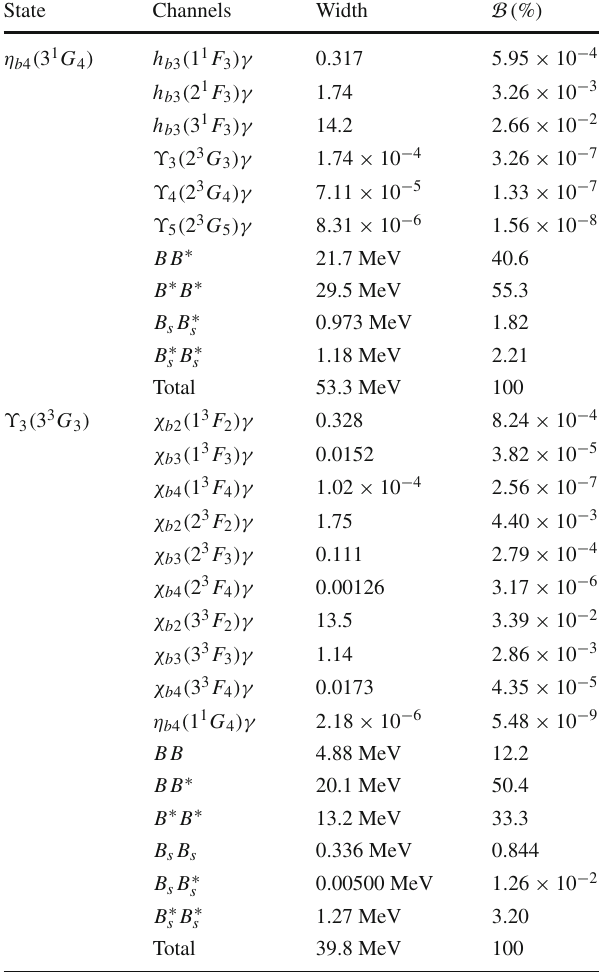
Table 40 Partial widths and branching ratios of OZI-allowed strong decay and, radiative transition and the total widths for 3 3 G 4 and 3 3 G 5 bottomonium states. The width results are in units of keV